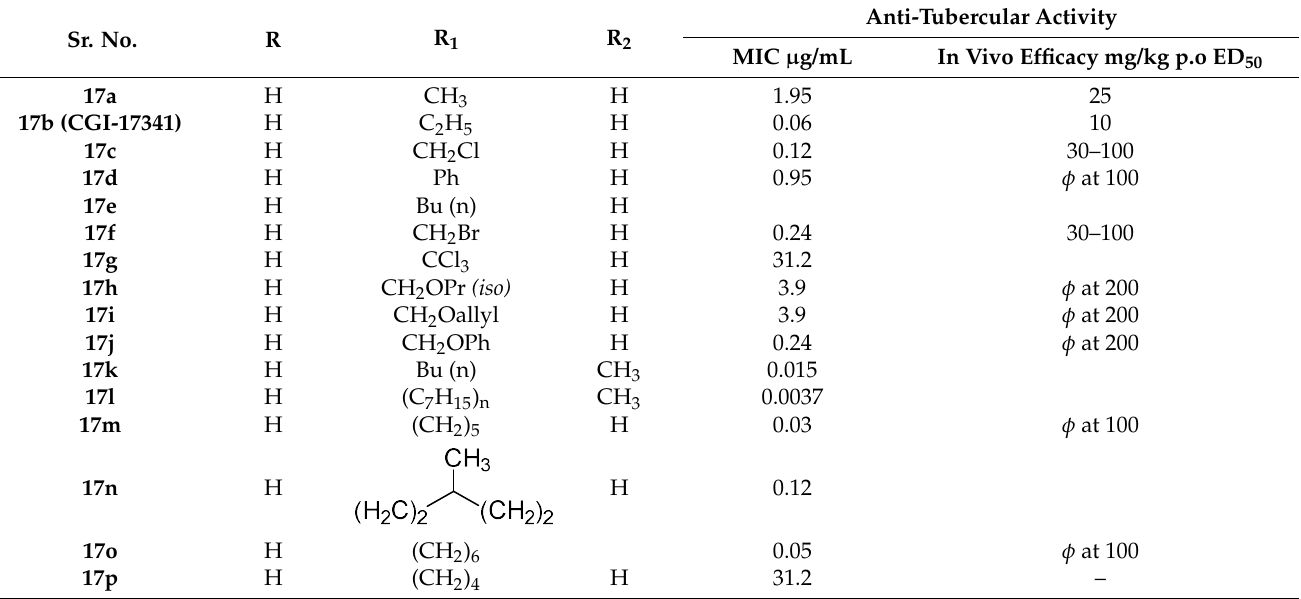
Figure 22. Activity profile of Delamanid 18 [170,171]. The first synthesis of Delamanid 18 was performed by Sasaki et al. in 2006, which involved the preparation of two key fragments (fragments 1 and 2) (Scheme 62). The synthesis of fragment 1 involved the nucleophilic attack of imidazole on epoxide in the presence of base trimethylamine, followed by deprotection, mesylation and epoxide formation. Simultaneously, 2-(4-bromophenoxy)tetrahydropyran was reacted with 4-(4-trifluoromethoxy)phenoxypiperidine to produce the intermediate, which upon deprotection with pyridinium p -toluenesulfonate in ethanol, produced the